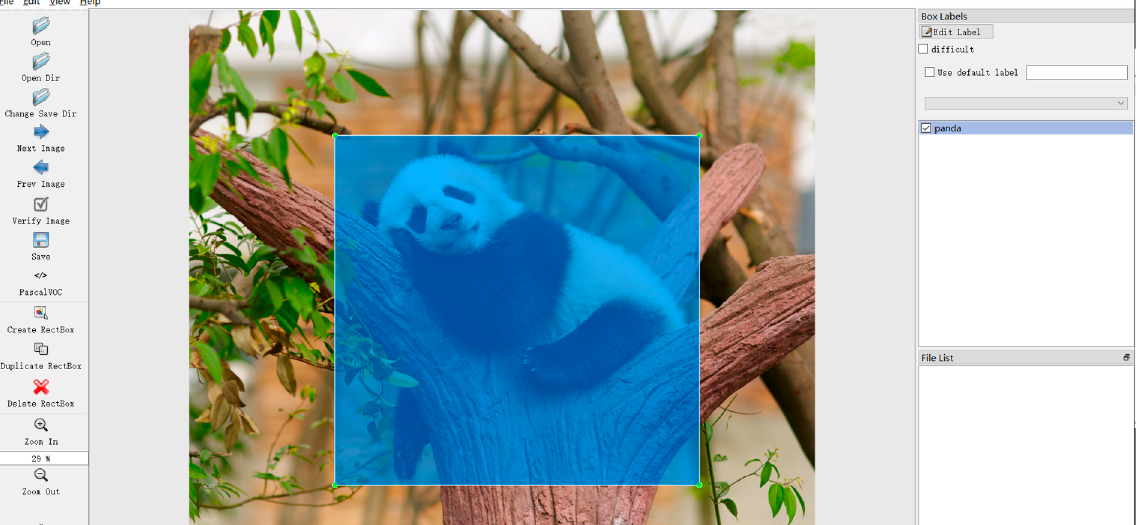
Figure 10. The process of changing animal fi gures to XML format.